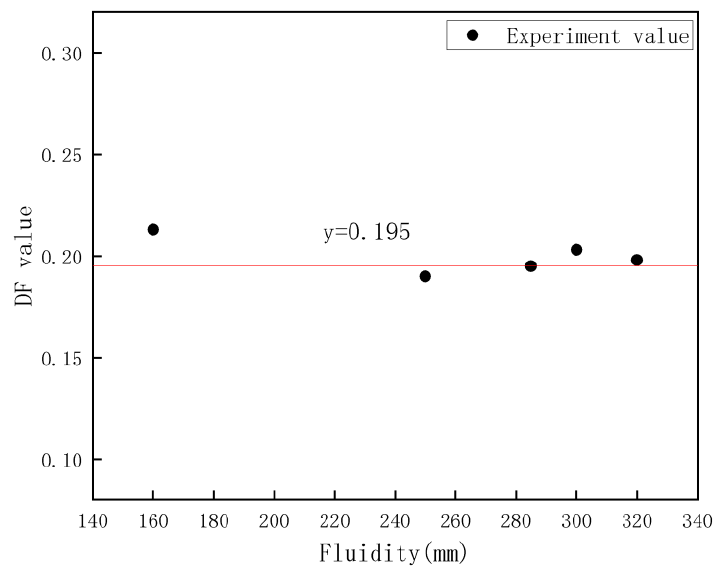
Figure 4. Relations between DF value and viscosity.